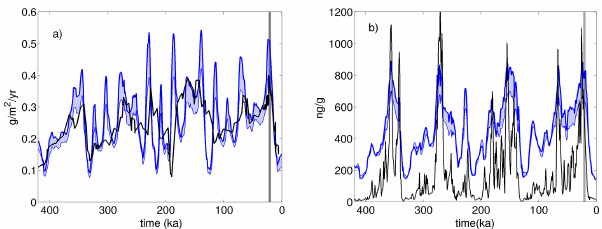
Figure 2. Time series of regional dust deposition for the past 420kyr. (a) Simulated range of dust deposition (blue shaded) from solutions L1 with a high dust lifetime (thick line) and L2 with a low dust lifetime (thin line) for the equatorial Pacific in gm − 2 yr − 1 compared to data (black line) from Winckler et al. (2008). (b) As in (a) but for dust concentration (ngg − 1 ) in Antarctic ice compared to data from Augustin et al. (2004). Vertical grey bars as in Fig.